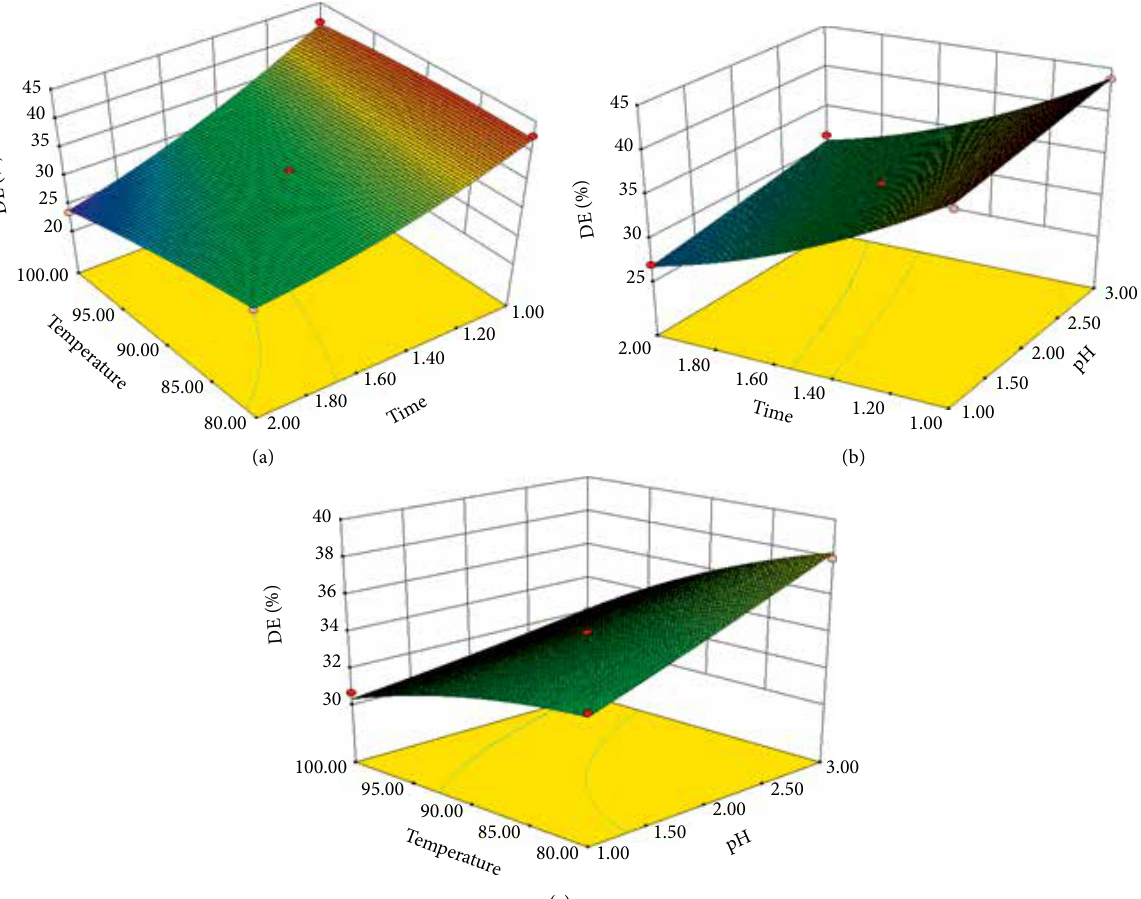
Figure 4: Surface plots for DE of pectin extracted by citric acid. (a) Effect of extraction time and temperature on the DEc with pH of 2. (b) Effect of extraction time and pH on the DEc with extraction temperature of 90°C. (c) Effect of extraction temperature and pH on the DEc with extraction time of 1.5